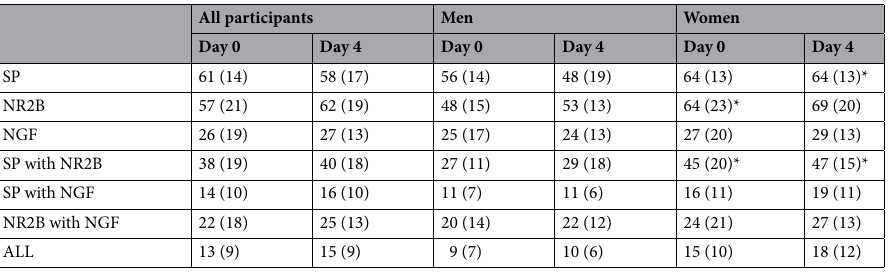
Table 3. The frequency (%) expression of nerve fibers within connective tissue. The table presents the mean (SD) frequency of nerve fibers expressing markers alone and co-expressions (SP with NR2B, SP with NGF, NR2B with NGF, or All), from all participants, men, women on day 0 and 4. All = SP with NR2B and NGF. *Significant differences between men and women (Bonferroni; P < 0.05) within day 0 or day 4.